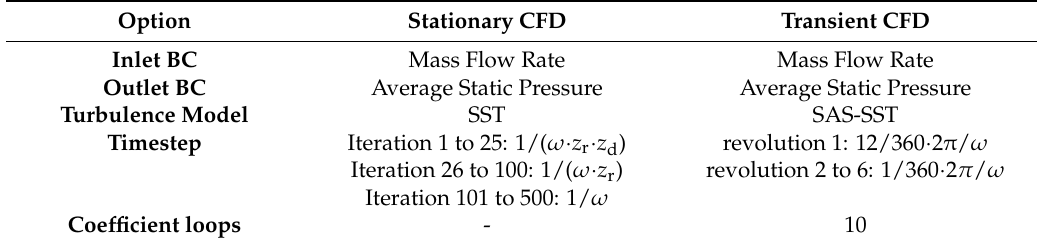
Table 3. General computational fluid dynamics (CFD) settings.